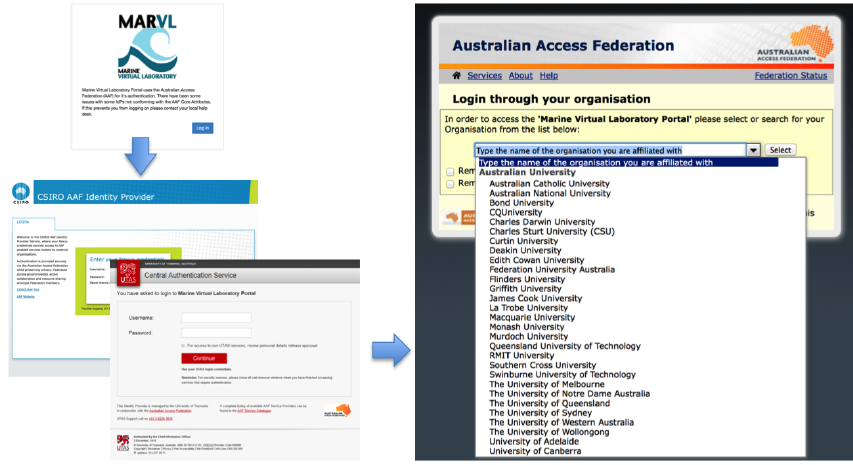
Figure 2. Screenshots of sample WebMARVL login